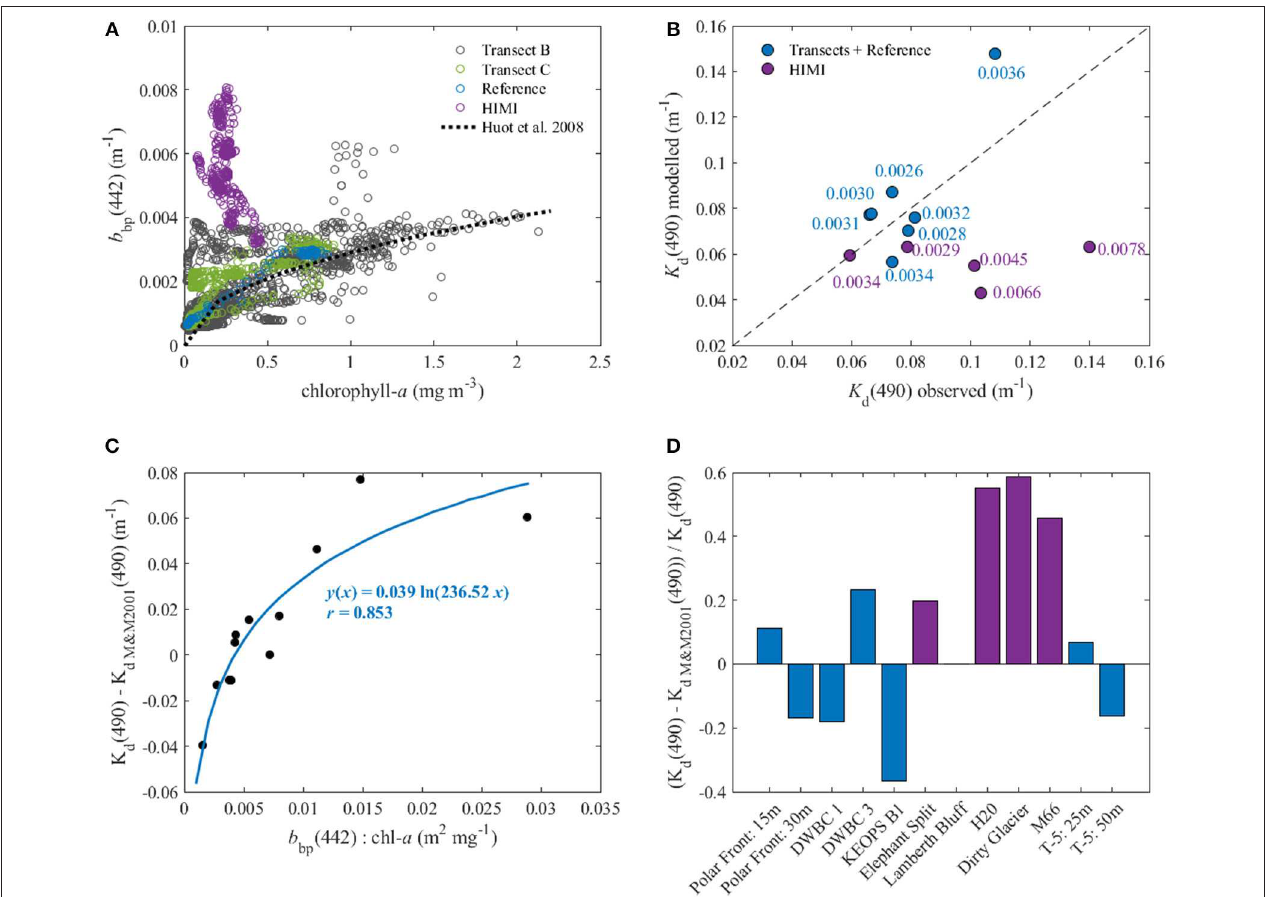
FIGURE 10 | (A) Relationship between chlorophyll a concentration (chl- a ) and particulate backscattering at 442nm [ b bp (442)]; the black dotted line is the relationship between particulate backscattering coefficients at 442nm and chl- a obtained for Case 1 waters (Huot et al., 2008); (B) comparison between the observed and modeled ( Morel and Maritorena, 2001) values of K d (490); the numbers are the values of b bp (442) and the black dashed line is the 1:1 line; (C) dependency between K d_NAP (490) { = K d (490)—[ K d_sw (490) + K d_sw (490)]} and the ratio between b bp (442) and chl- a ; the line is the best fit line to the data; (D) relative contribution of the light attenuation of non-algal particles to total light attenuation in the studied